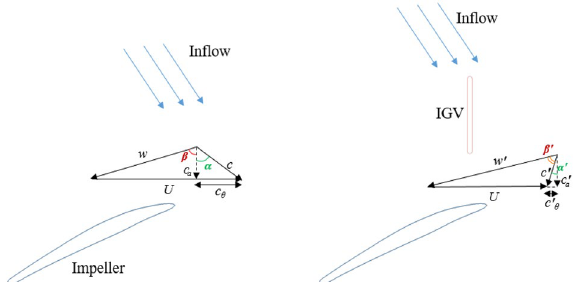
Figure 1. Inflow direction and velocity